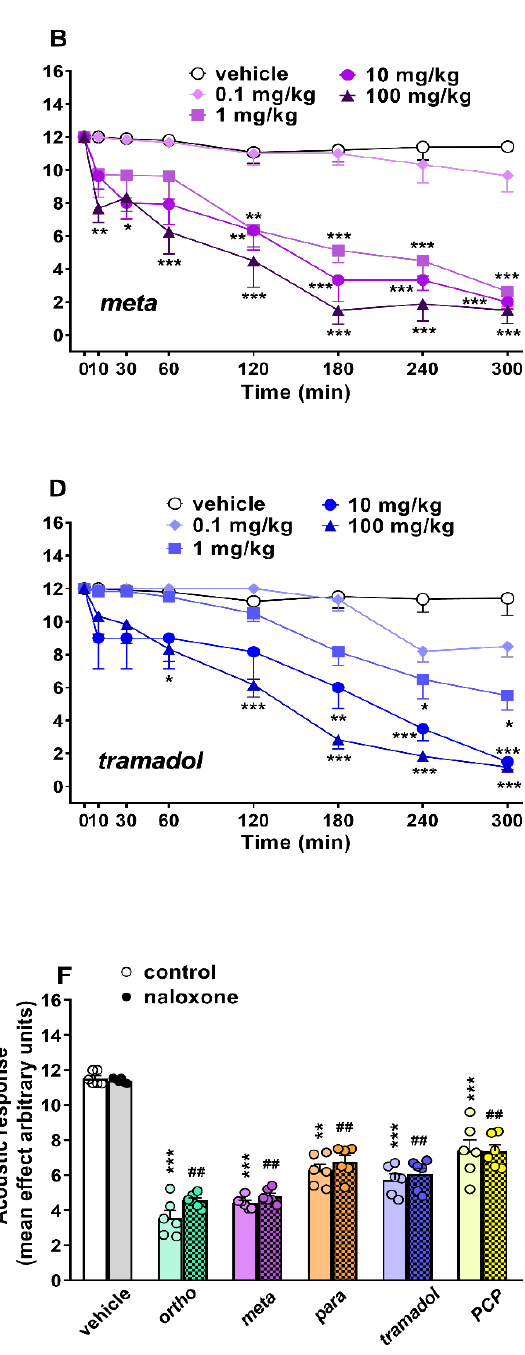
Figure 5. Effects of the systemic administration (0.1–100 mg/kg i.p.) of ortho ( A ), meta ( B ), para ( C ) and tramadol ( D ) on the acoustic response in mice. Comparison of the maximal effect of ortho, meta, para, tramadol (0.1–100 mg/kg) and PCP (0.01–10 mg/kg) observed over 5 h ( E ) 2 . Interaction of the effects of ortho, meta, para, tramadol (100 mg/kg) and PCP (10 mg/kg) with the opioid receptor antagonist naloxone (6 mg/kg, i.p.; ( F )). Data are expressed as arbitrary units and represent the mean ± SEM of 6–8 determinations for each treatment. Statistical analysis was performed by two-way ANOVA, followed by the Bonferroni’s test, for multiple comparisons of the dose–response curve of each compound at different times ( A – D ), and for the antagonist studies ( E ), while the statistical analysis of panel F was performed with one-way ANOVA followed by Bonferroni test for multiple comparisons. * p < 0.05, ** p < 0.01, *** p < 0.001 versus vehicle; d p < 0.05 versus meta; ## p < 0.01 versus naloxone; 2 PCP data are elaborated from [17].